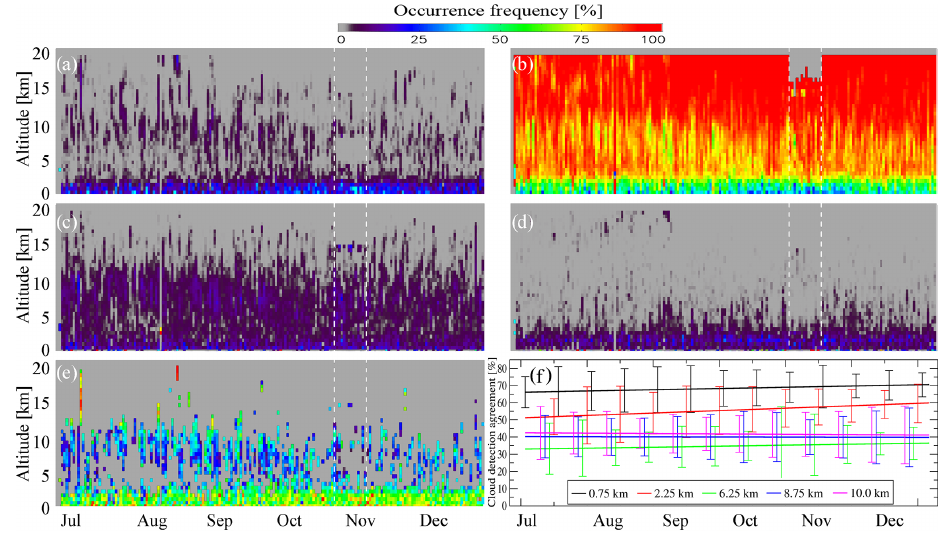
Figure 11. Temporal evolution of occurrence frequencies for (a) R YES_YES (z, time ) , (b) R NO_NO (z, time ) , (c) R YES_NO (z, time ) , and (d) R NO_YES (z, time ) for the period of 28 June–31 December 2019. The legend is consistent with that of Fig. 9. Dashed white verti- cal lines correspond to the Air Motion Vector (AMV) campaign (28 October–10 November 2019), which is characterized by smaller bin sizes and, therefore, larger SNRs for Mie and Rayleigh channels up to the height of 2250m. (e) Normalized cloud detection agreement CDA norm (z, time ) . (f) Same as (e) presented for five heights as linear fits in 2D with error bars. The error bars were estimated as root-mean- square values for 1-week chunks of altitude